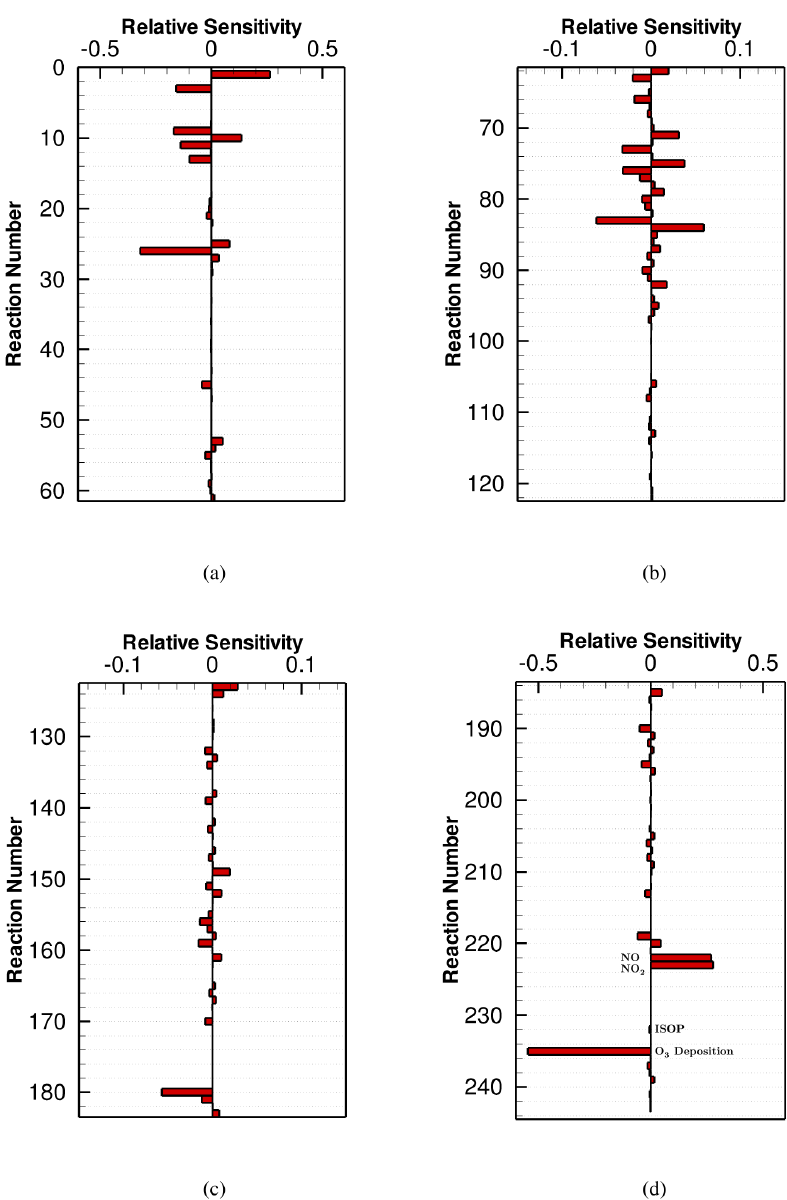
Figure 2. Averaged ozone sensitivity to the CB6r3 mechanism over the seventh day, when the surface emission is weak. Note that the horizontal scales of the sub-figures are different. All the values of the sensitivities shown in this figure can be found in Table S1 in the